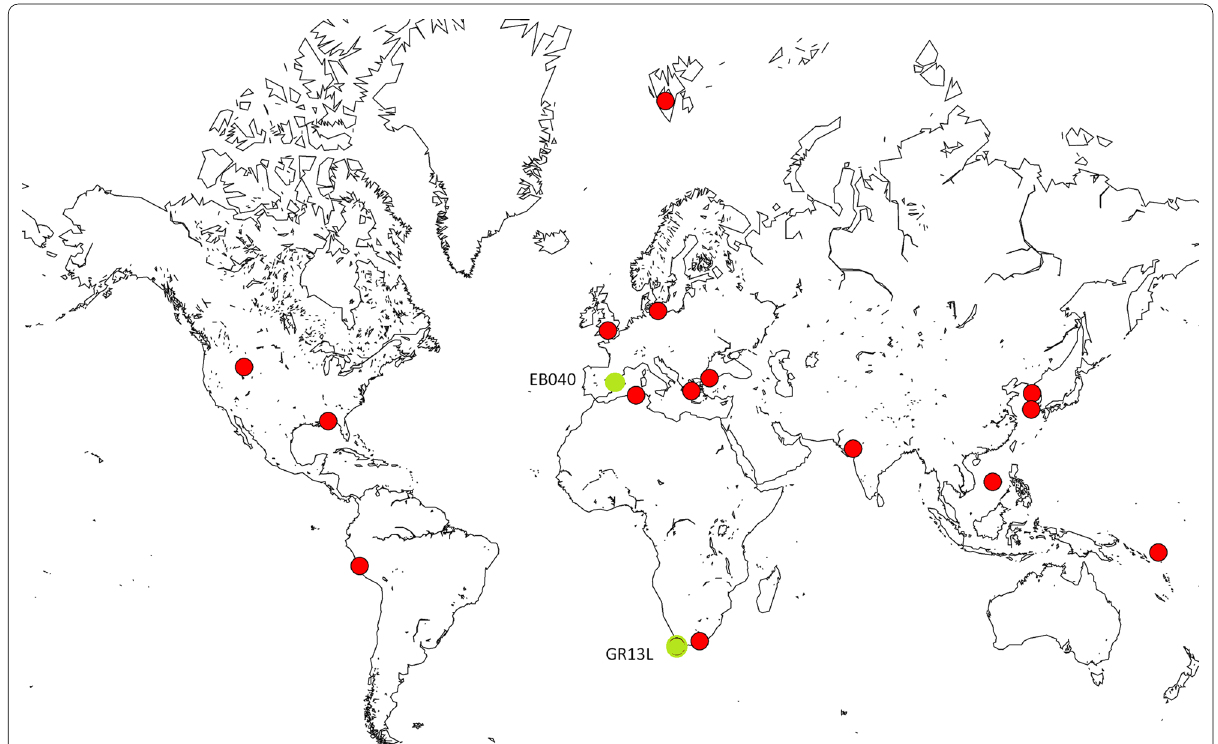
Fig. 10 Locations of the ionosonde stations used for the validation. The two stations EB040 and GR13L for which the validation is performed are marked in “green”